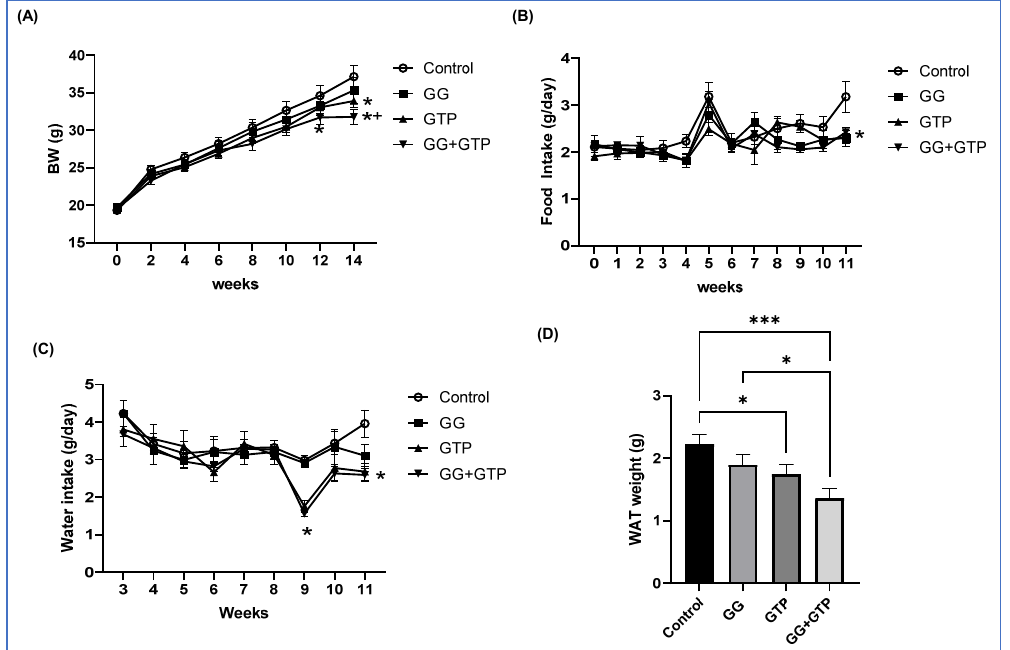
Figure 1. Effects of GGOH and GTPs on BW, food intake, water intake, and WAT weight in male mice fed an HFD. ( A ) Body weight, ( B ) food intake, and ( C ) water intake over time. ( D ) Final WAT weight: two-way ANOVA found no interaction effects ( A – D ). BW, body weight; Control, HFD only; GG, HFD supplemented with GGOH in 400 mg/kg diet; GTPs, HFD supplemented with 0.5% weight/volume GTPs in water; GG + GTPs, HFD supplemented with a combination of GGOH and GTP; WAT, white adipose tissue; *, p < 0.05 compared to the control; +, p < 0.05 compared to GG for ( A – C ); *, p < 0.05; ***, p < 0.001 by Fisher’s Least Significant Difference (LSD) test post hoc analysis ( D